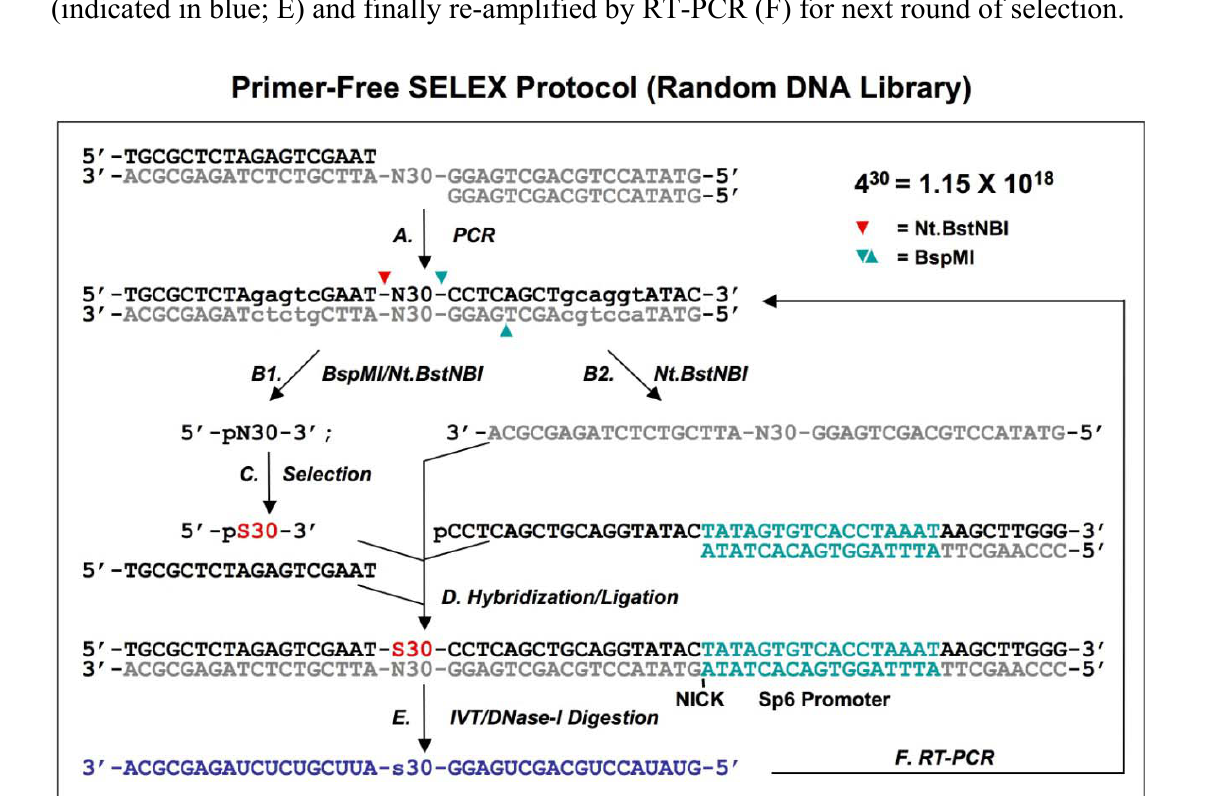
Figure 8 . Schematic representation of the primer-free random DNA library